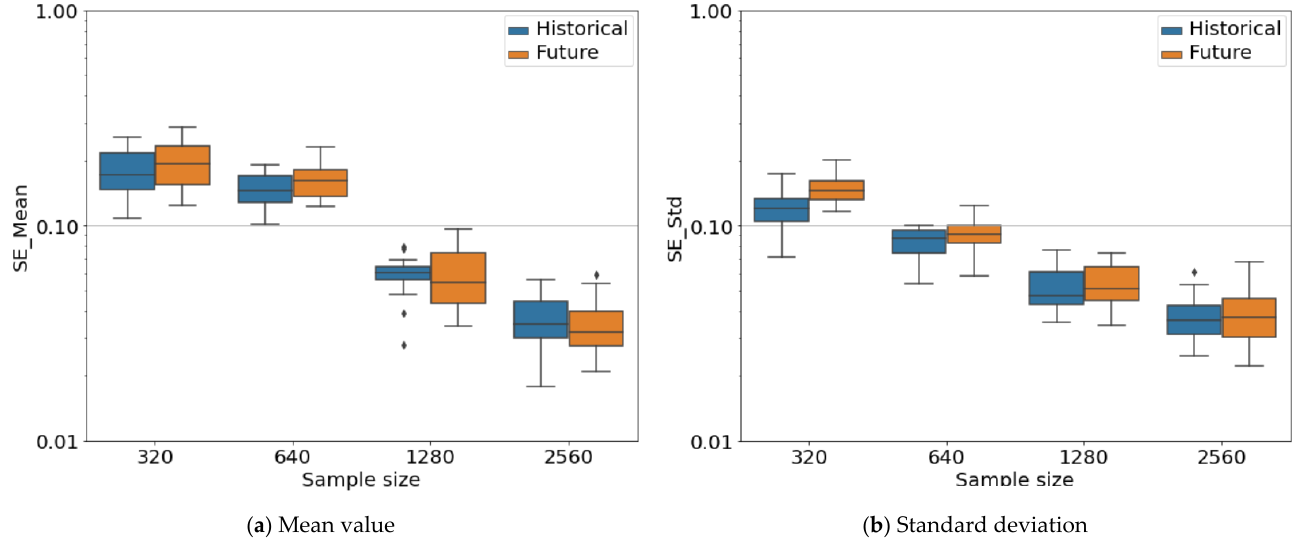
Figure 15. Convergence rate for different orientations. Note: there are 16 orientations, therefore, the sample size for each orientation is roughly equal to the total sample size divided by 16. The marks of “ ⧫ ” are outliers.